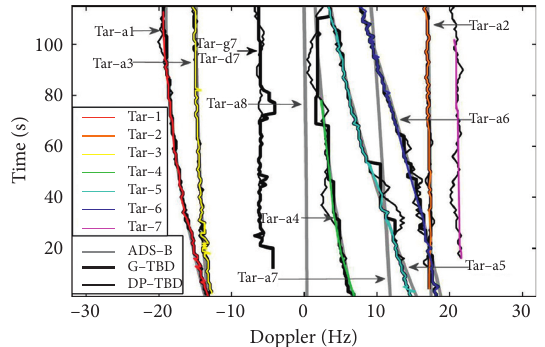
Figure 17: TBD result of time-doppler